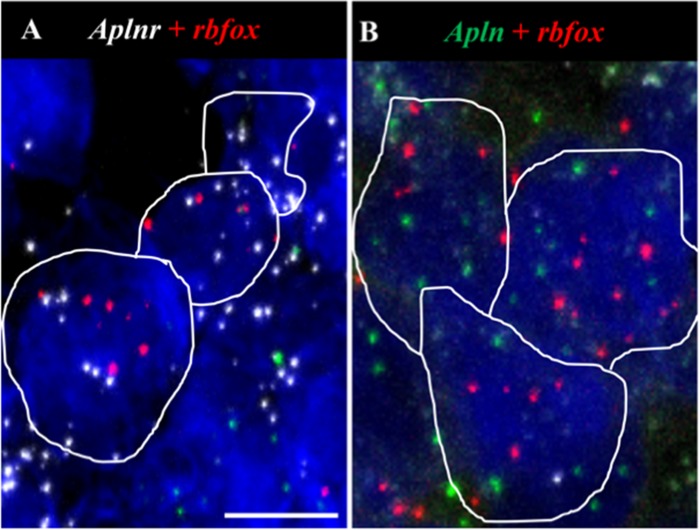
Aplnr and apln transcripts co-localise with rbfox in the AP.(A,B) Representative fluorescent images showing colocalization of aplnr (white dots, A) and apln (green dots, B) with rbfox (red) in the AP. Scale bar = 10μm. n = 4.